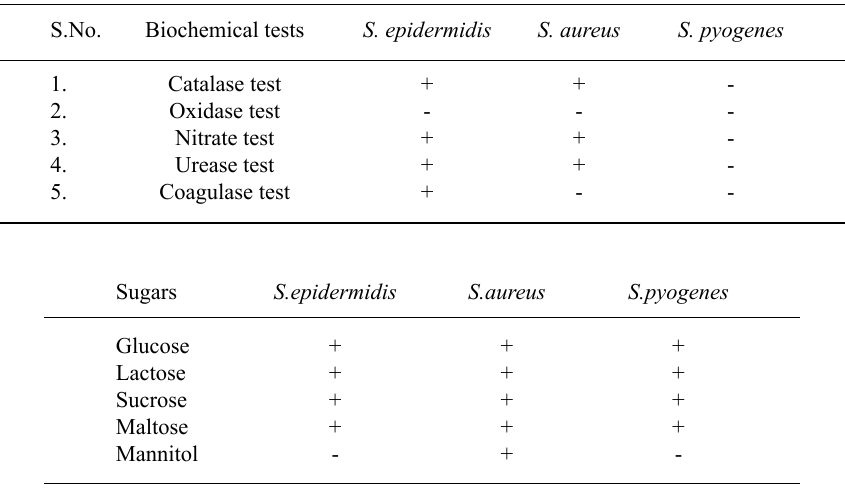
Table 1. Biochemical tests and Sugar Fermentation